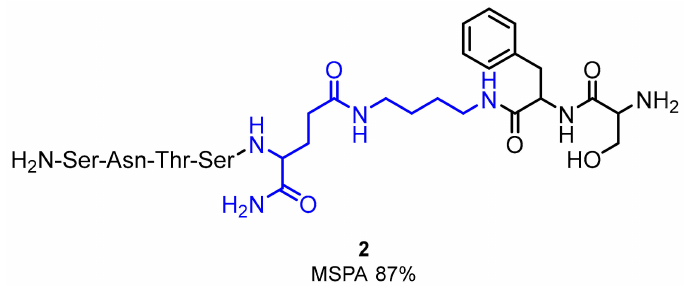
Figure 2. An example of modified heptapeptide (SNTSEFS-NH 2 ) derived from 1 (modified moiety is coloured with